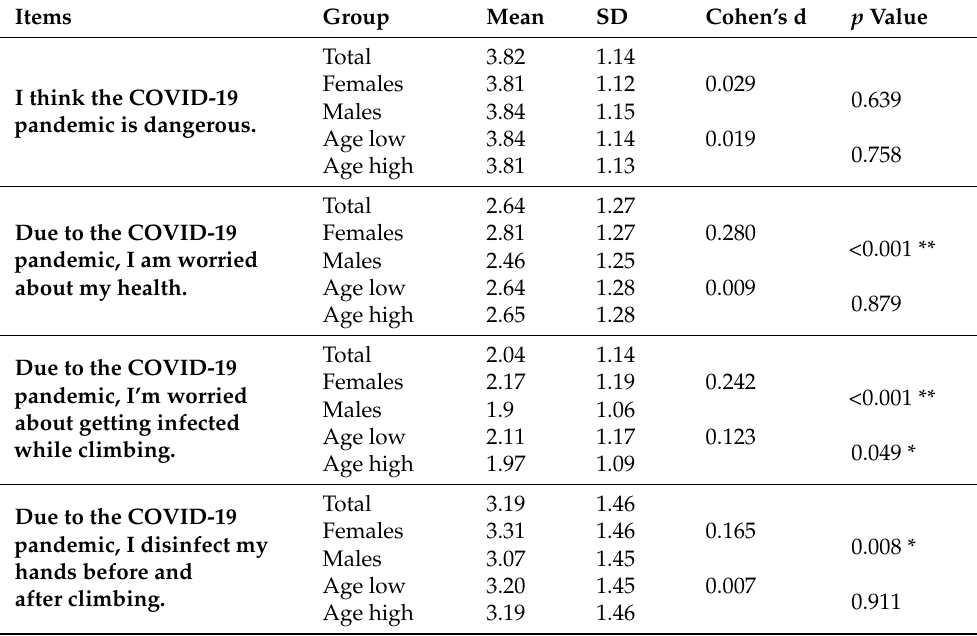
Table 2. Subgroup-specific responses to items related to the COVID-19 pandemic and